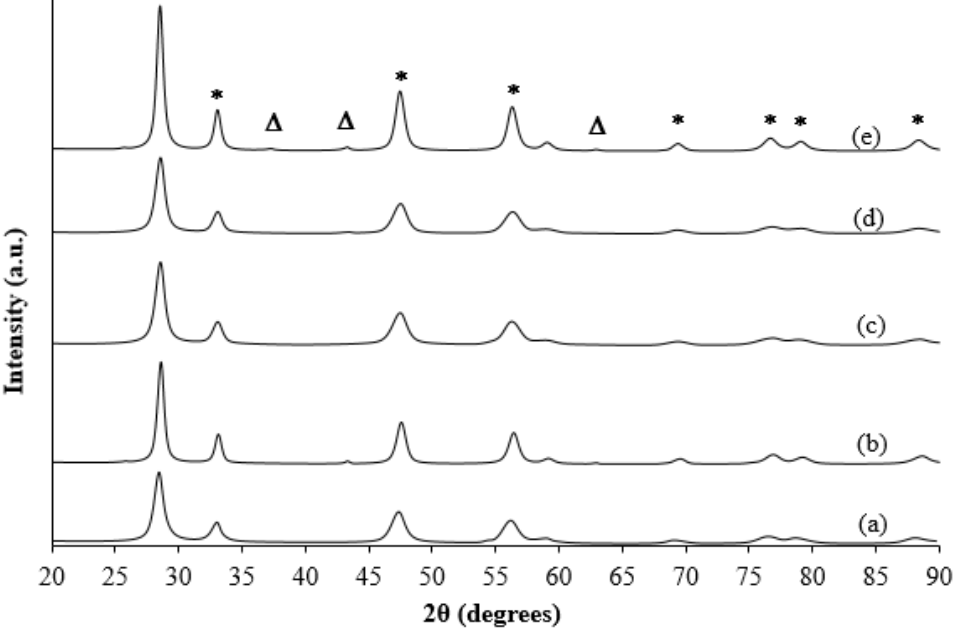
Figure 1. XRD patterns of Ni catalysts, ( a ) CeO 2 (combustion), ( b ) 5%Ni/CeO 2 (combustion), ( c )